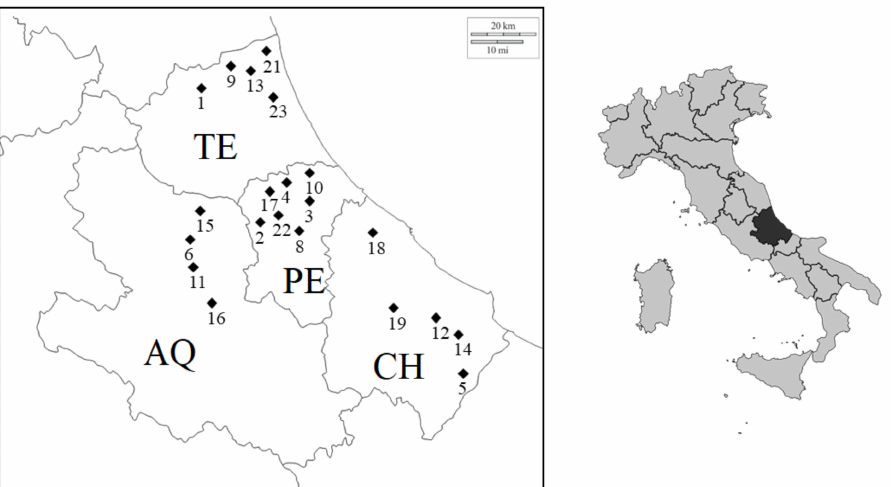
Figure 1. Location of the cultivation sites of the investigated wines within the four provinces, L’Aquila (AQ), Teramo (TE), Pescara (PE) and Chieti (CH), of the Abruzzo